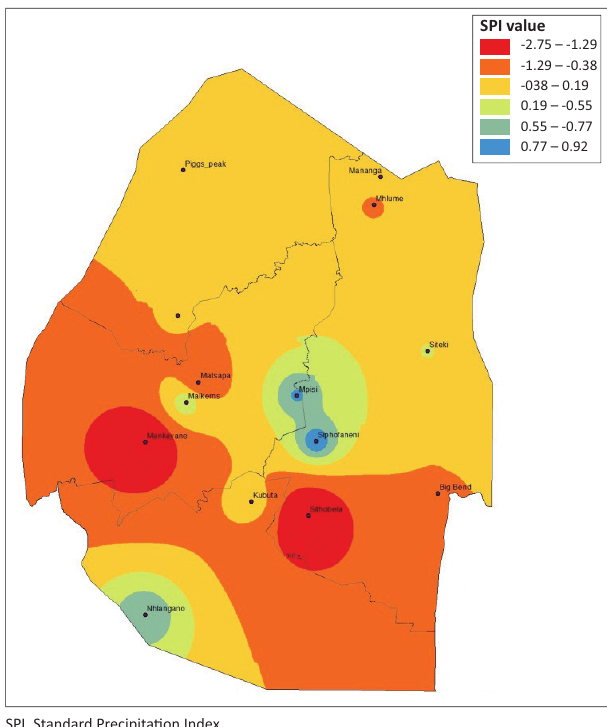
FIGURE 8: Standard Precipitation Index 3-month timescale during 2005–2006.